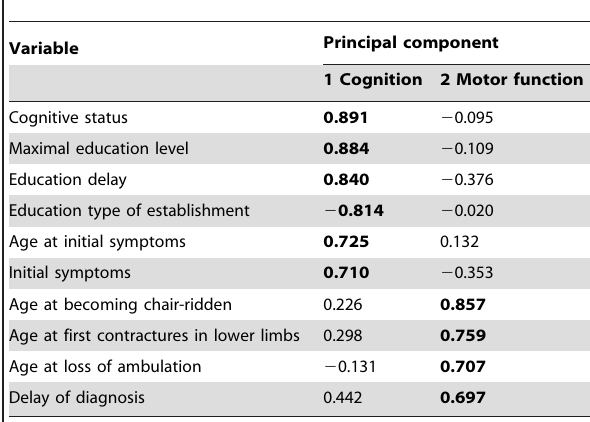
Table 2. Variables’ contributions to the two principal components (Cronbach’s a , a measure by default for the internal consistency of categorical principal components in the SPSS software, is 0.891 and 0.721), absolute values above 0.500 were retained to define the principal